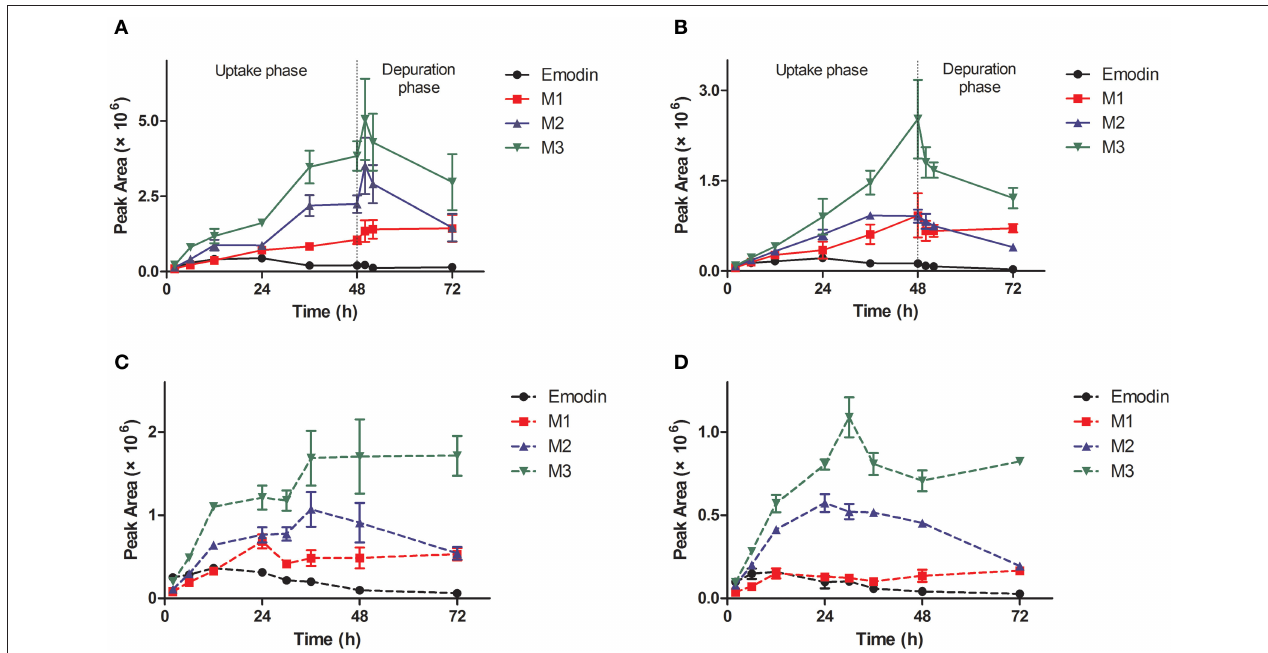
FIGURE 3 | Profiles of metabolites of emodin in zebrafish eleutheroembryos in the standard test (A,B) and the modified test (C,D) at high and low concentrations. M1, sulfated emodin; M2, glucosylated emodin; M3, glucuronidated emodin.